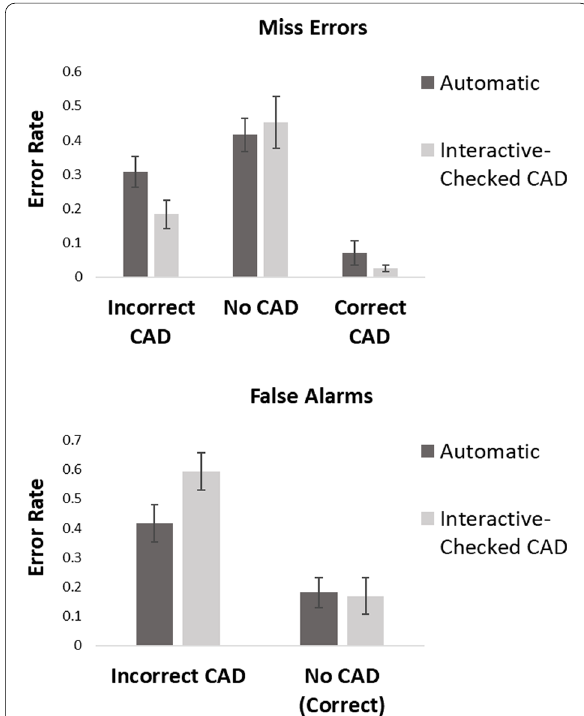
Fig. 4 Proportion of miss errors and false alarms in the automatic and interactive checked CAD conditions of Experiment